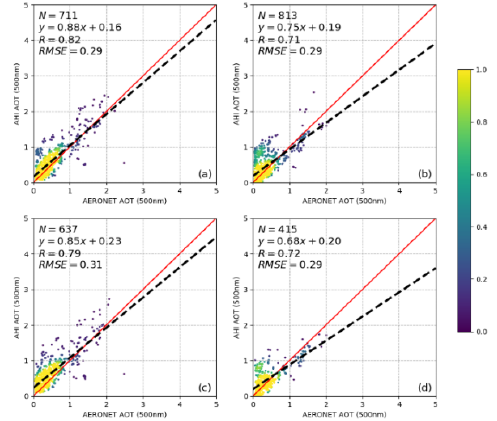
Figure 2. Comparison of AHI hourly combined AOTs against with AERONET AOT at 500nm in Beijing from January 2018 to December 2018 based on the quality assurance flag of surface reflectance confidence; the red solid line is the 1:1line and the black dashed line indicate the regression line.